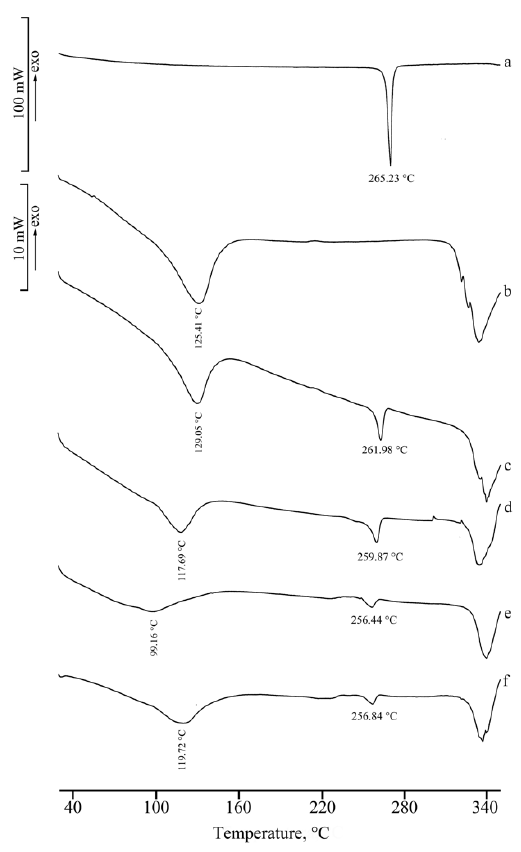
β -CD ( b ), their PM ( c ), and KN ( d ), MW ( e ), and CP ( f ) Figure 7. DSC curves of RSV ( a ),  -CD ( b ), their PM ( c ), and KN ( d ), MW ( e ), and CP ( f ) products. Figure 7. DSC curves of RSV ( a ),